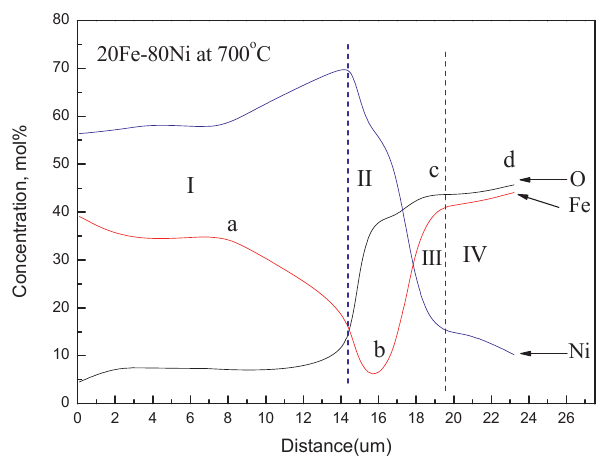
Figure 4. Concentration profiles across 20Fe-80Ni alloy at 700 ı